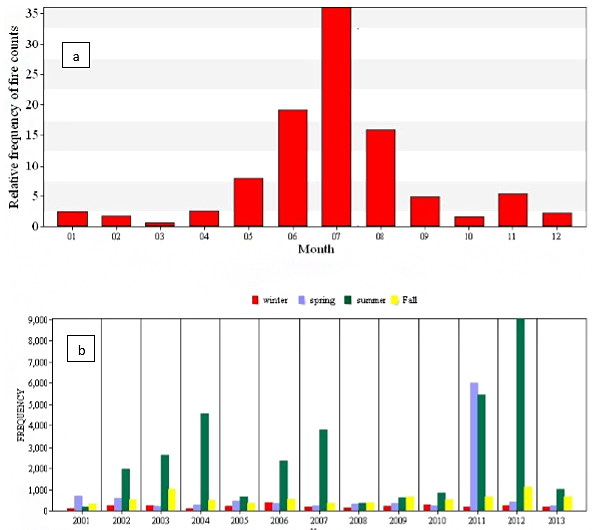
Figure 13. MODIS true image combined with fire points (red) on (a) 10 July 2012 and (b) 11 July 2012. (c) MOPITT CO total col- umn from 10 to 20 July 2012 over Alberta and (d) MOPITT surface CO from 10 to 20 July 2012 over